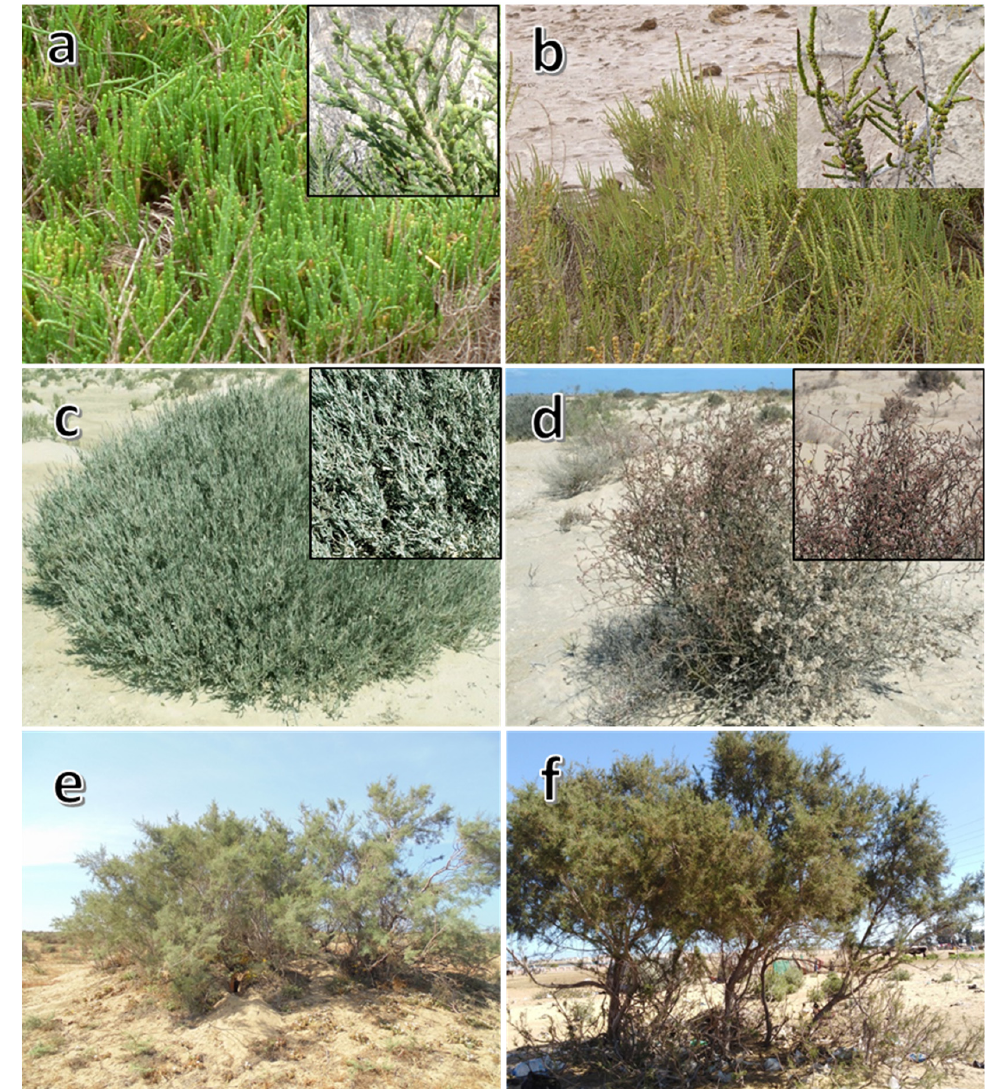
Figure 1. Overview of different studied halophytes. ( a ) Arthrochemum macrostachyum, ( b ) Halocnemum strobilaceum, ( c ) Limoniastrum monopetalum, ( d ) Limonium pruinosum, ( e ) and ( f ) Tamarix nilotica.